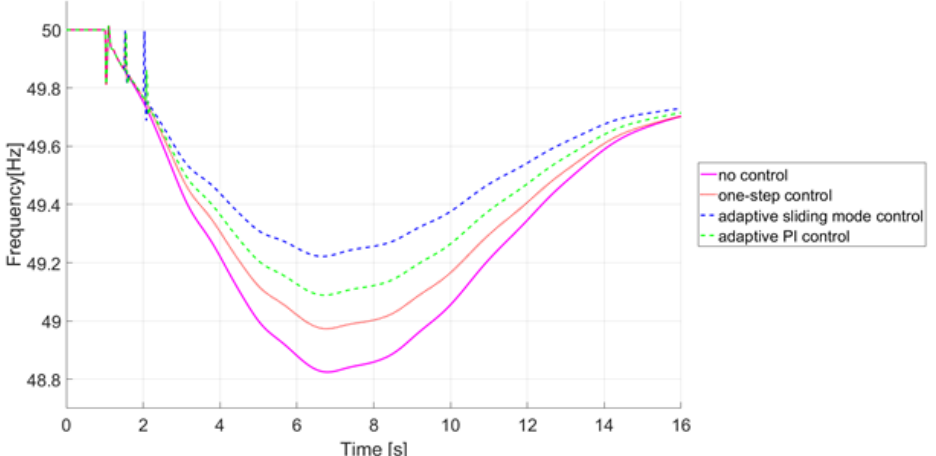
Figure 9. Frequency at bus 39 in Configuration I in case of big disturbance.